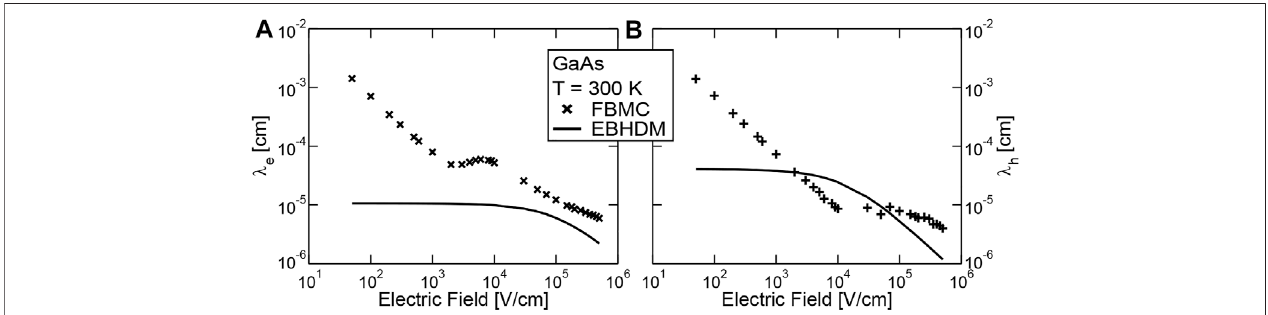
FIGURE9| Dependenceofthe λ e and λ h parametersvs.theelectric fi eld.ThecrossesaretheresultsofFBMCsimulationsofuniformGaAsregionsunderconstant electric fi eldwhere Eq.24 isusedtocompute λ e and λ h fromtheaveragecarrier energy.Thelinesarethebest fi tsof Eq.26 thatmakestheEBHDMreproducethe α ( x ′ | x ) and β ( x ′ | x ) from FBMC (examples in Figure 7 ).